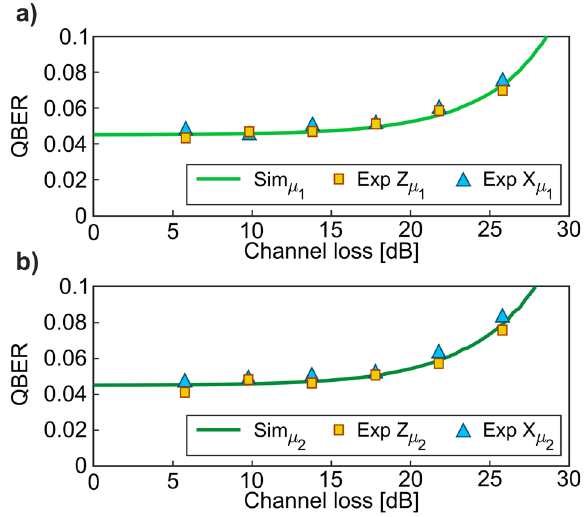
Fig. 4 Quantum bit error rate. Simulation (solid lines) and experimental values for the Z (yellow squares) and X (blue triangles) bases for the intensities μ 1 ( a ), and μ 2 ( b ). Uncertainty values, computed as the standard error of the mean, are not displayed as error bars are covered by the markers.